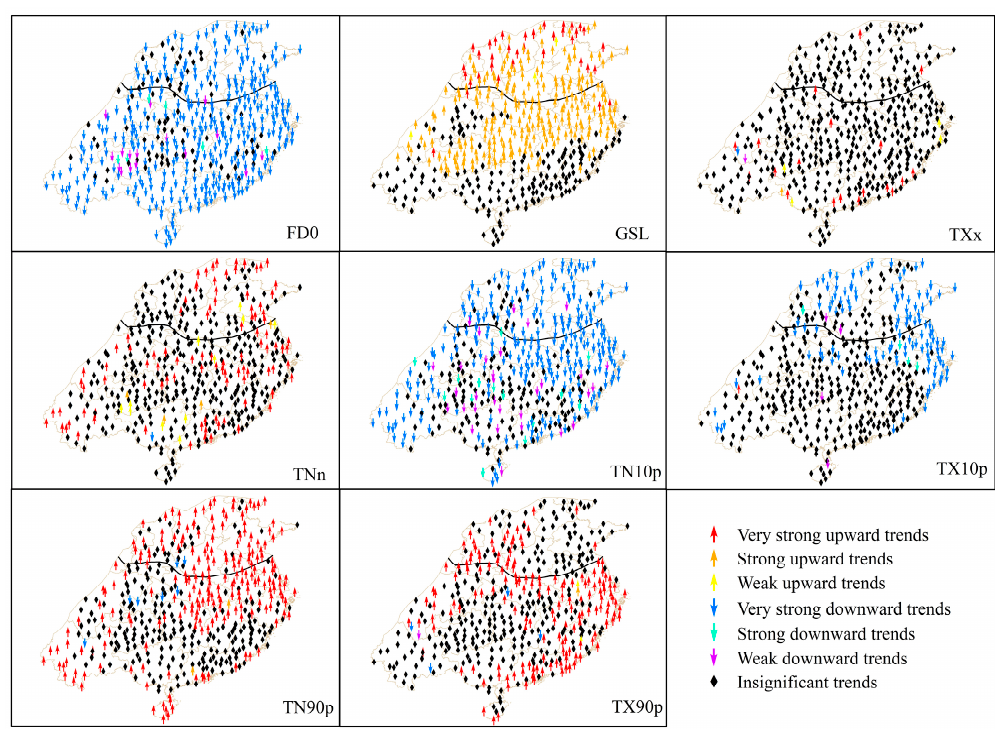
Figure 4. Spatial distributions of the trend strengths for the extreme temperature indices in the study area during the growth period of October 1961 to May 2016. Atmosphere 2019 , 10 , x FOR PEER REVIEW